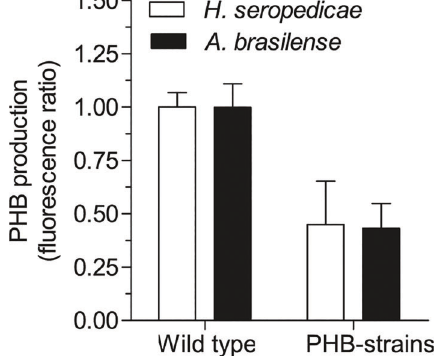
Figure 7. PHB production of epiphytic bacteria analyzed by fl ow cytometry. PHB measurements were performed using the opti- mized procedure on rice epiphytic H. seropedicae strain SmR1, a mutant strain of H. seropedicae , D phaC1 , A. brasilense strain FP2, and a mutant strain of A. brasilense , phbC SP7, 7 days after inoculation, as described in the Material and Methods. Fluores- cence ratio data are reported as means ± SD of 2 independent experiments performed in triplicate, using the median fl uores- cence intensity values in the FL2-H